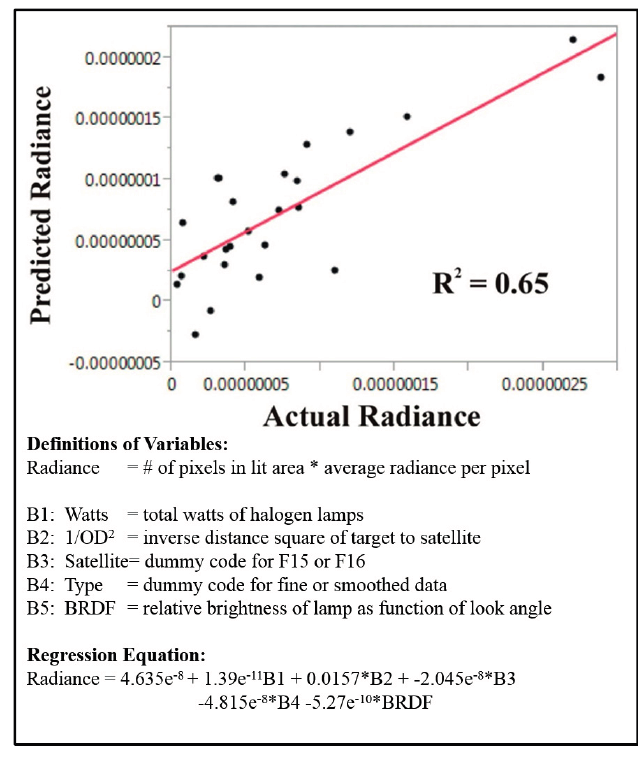
Figure 5. Results of Linear Regression incorporating Angular Variation of Light Intensity